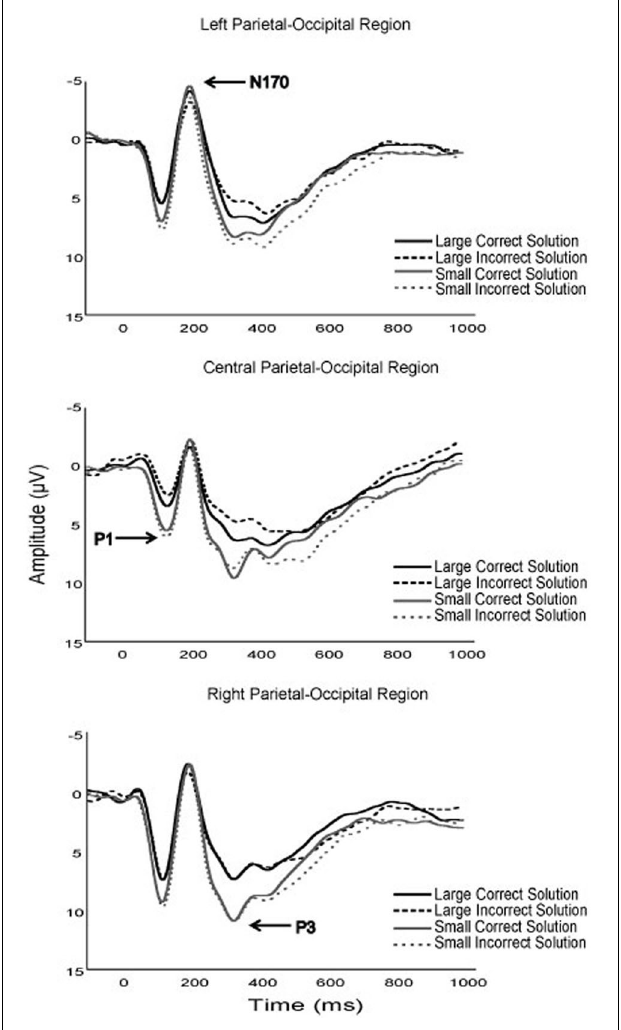
FIGURE 2 | Grand average waveforms of the P1, N170, and P3 components for all participants, for all task experimental task solution